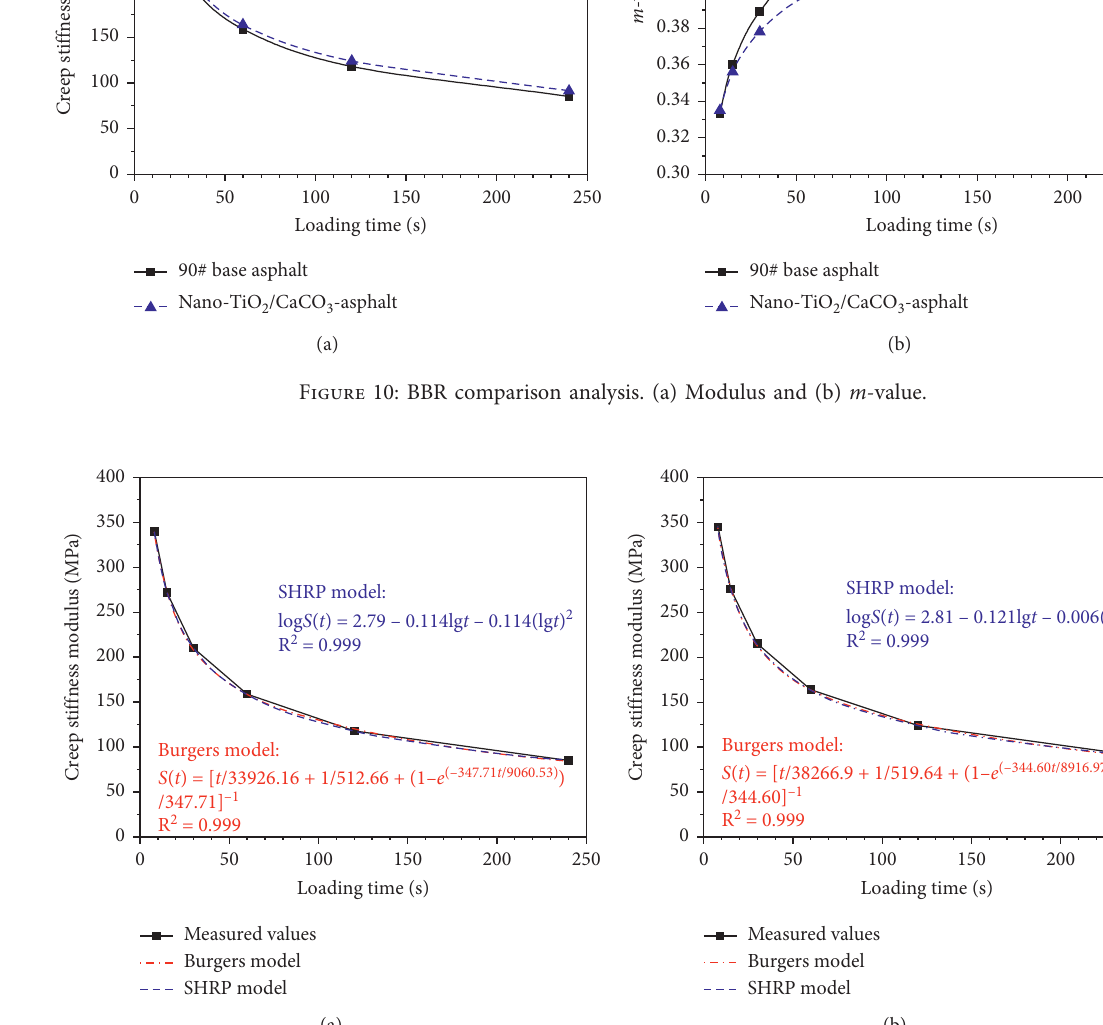
2 /CaCO 3 -modified